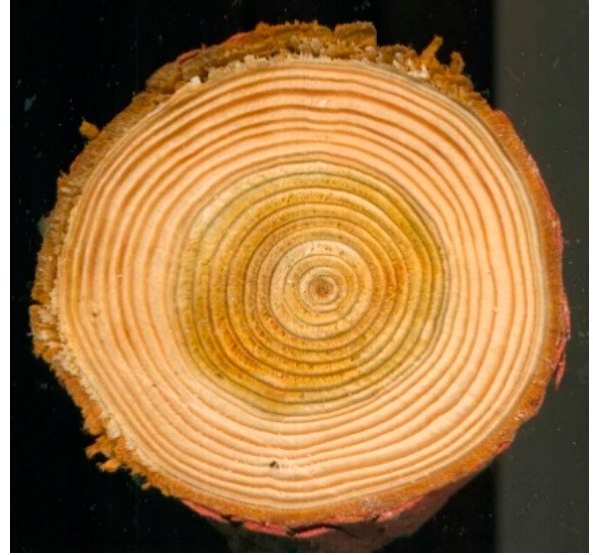
Figure 1. Dahurian larch disc sample.